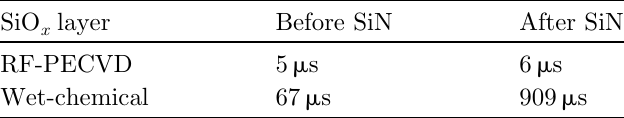
Table 2. Lifetime of symmetric samples from Batches 2 \( p + ) m c-Si before and and 3 on FZ wafers with wet SiO x :H (no annealing step). after deposition of SiN x